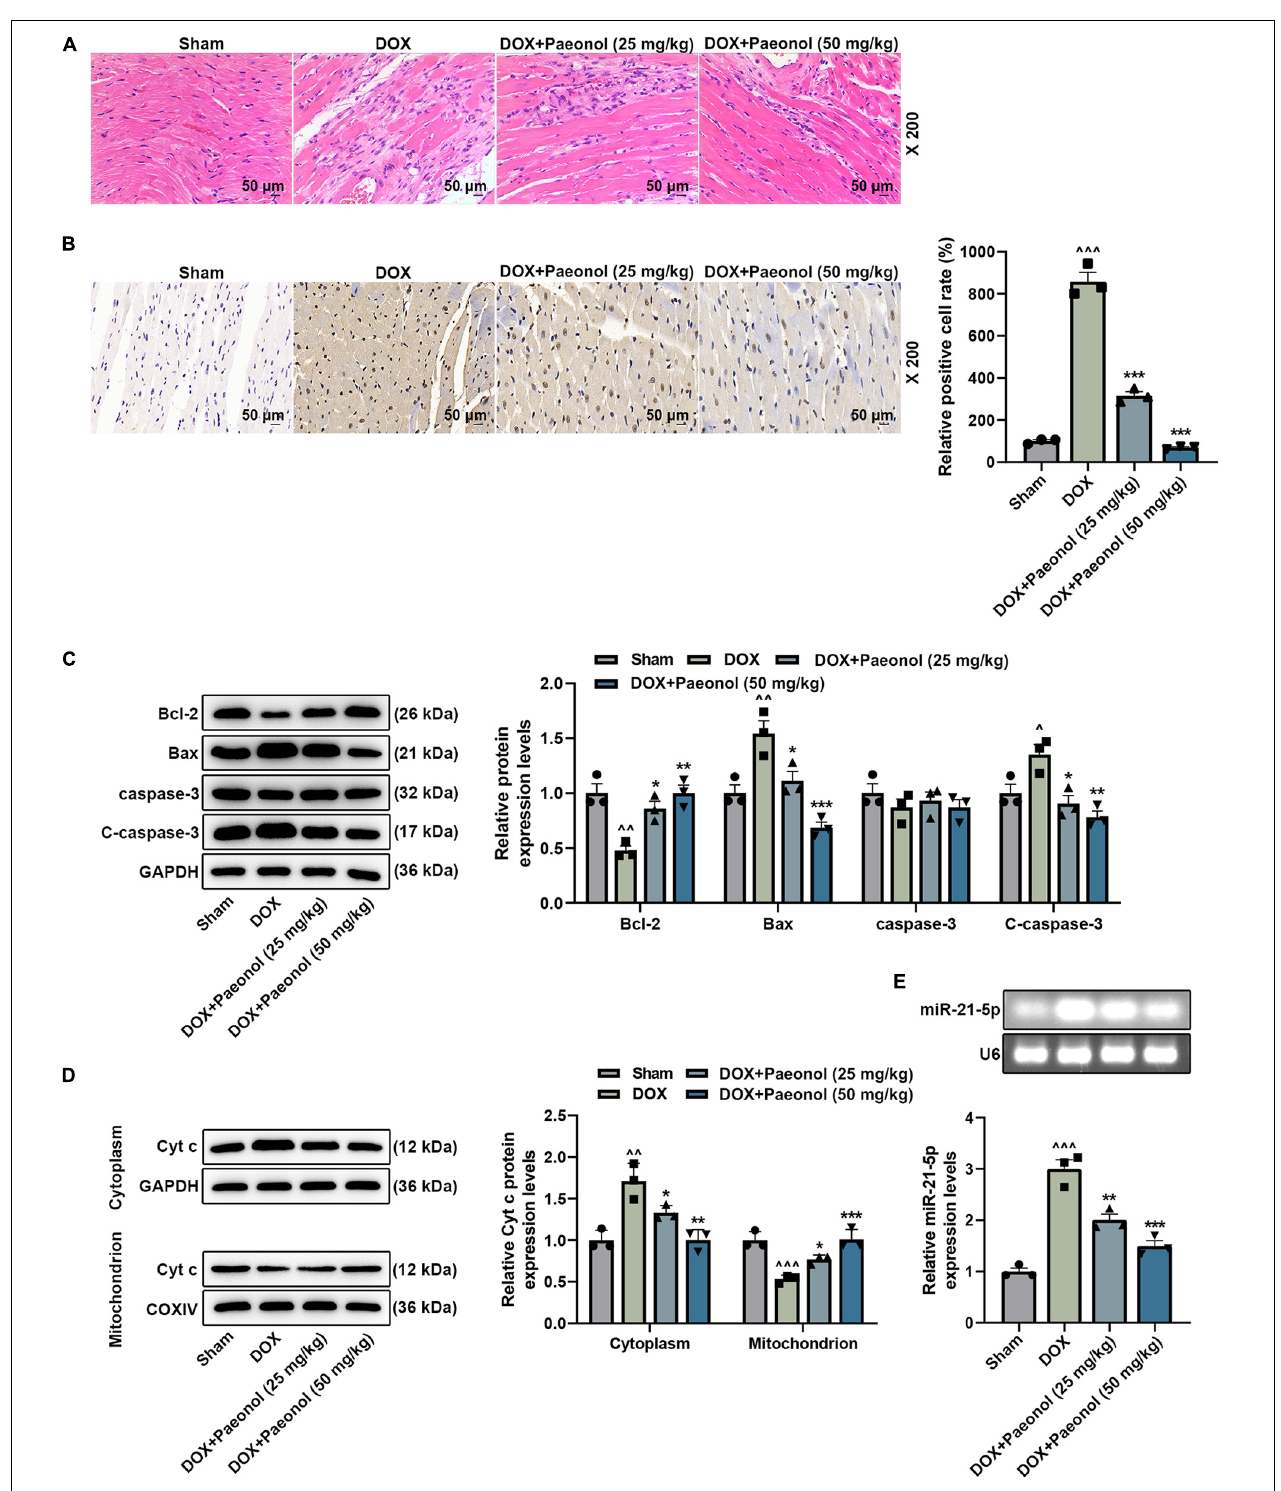
FIGURE 2 | Paeonol ameliorated histopathological injury, suppressed apoptosis, and downregulated the miR-21-5p expression in the myocardium of CHF rats. (A) The myocardial histopathology of the rats was detected by hematoxylin–eosin staining (magnification of × 200). (B) The myocardial apoptosis of the rats was detected by TUNEL staining (Magnification: × 200). (C,D) The levels of Bcl-2, Bax, caspase-3, C-caspase-3, and Cyt C in the myocardium of rats were detected by Western blot. GAPDH was used as an internal control. (E) The expression of miR-21-5p in the myocardium of rats was detected by RT-qPCR, with U6 serving as an internal control. ∧ P < 0.05, ∧∧ P < 0.01, ∧∧∧ P < 0.001, vs. Sham; * P < 0.05, ** P < 0.01, *** P < 0.001 vs. DOX. DOX, doxorubicin.